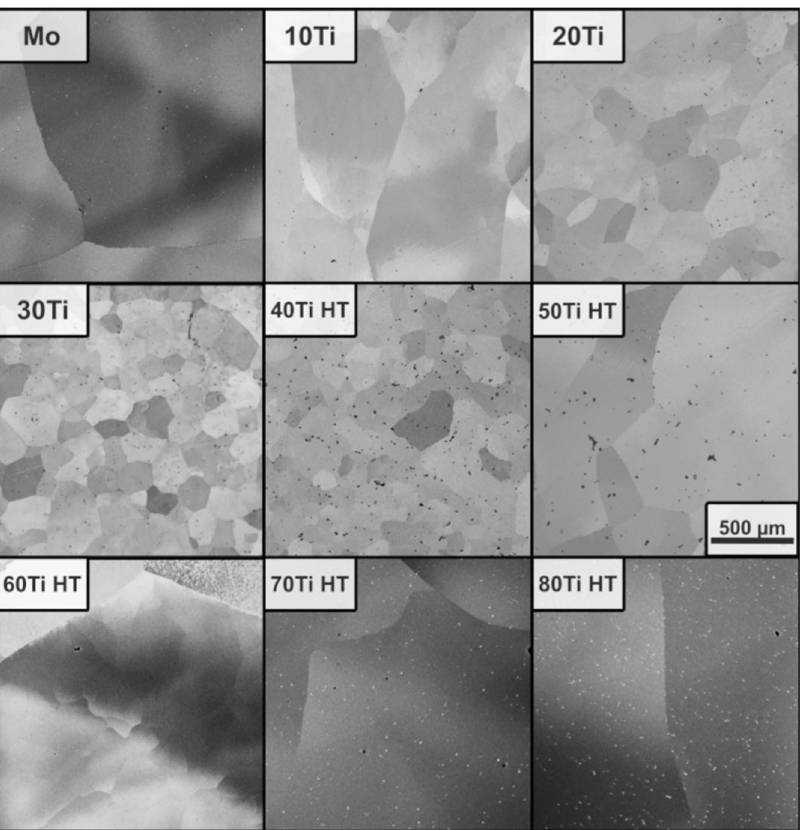
Fig. 6 Microstructure. SEM-BSE micrographs of the microstructures for Mo-Ti solid solutions. Alloys containing 40 at% Ti and more are shown after the homogenization treatment (HT). All micrographs are presented at the same magni fi